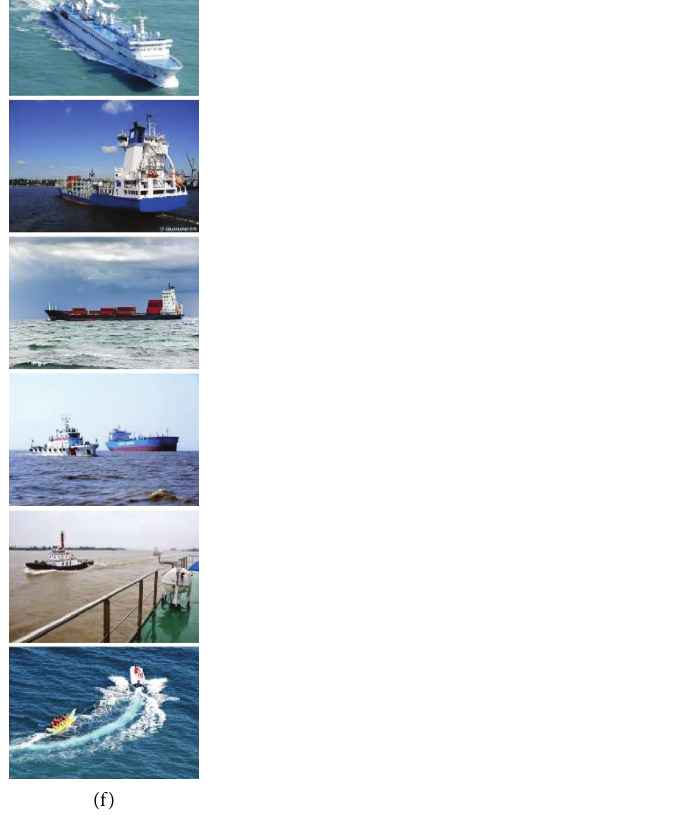
Figure 8: Visual comparisons of synthetic experiments on six images with transmission value � 0.5 and atmospheric light value � 0.9. From left to right: (a) synthetic haze image and dehazed images generated by (b) DCP [23], (c) RIVD [30], (d) MSCNN [12], (e) ours, and (f) original clear images, respectively.